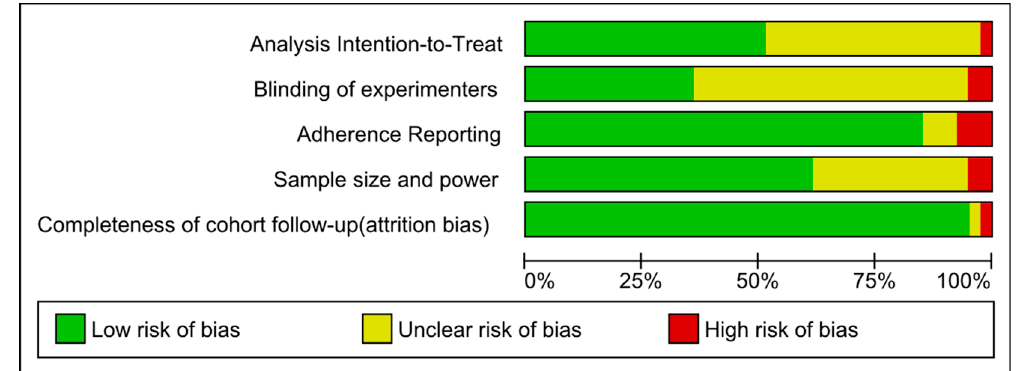
Figure 7. Risk of bias graph as percentages across all included studies.